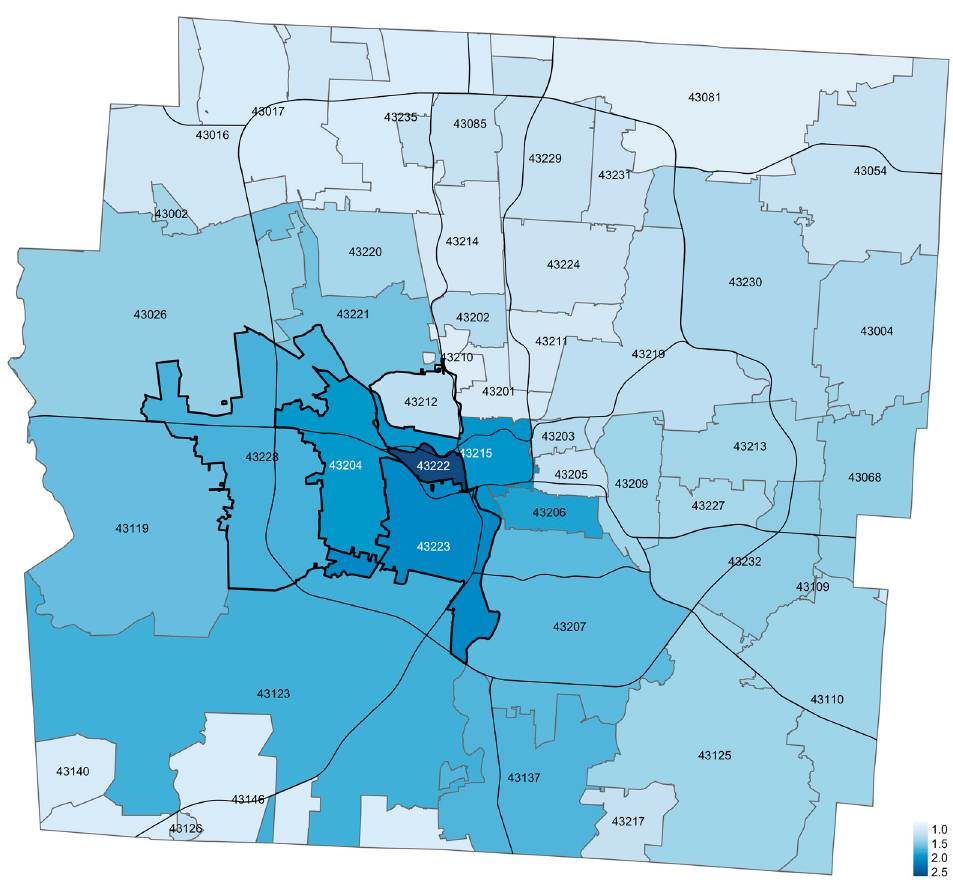
Figure 4. Franklin County, Ohio Bicycle Injury Density Map from 1 January 2015 to 28 February 2021. Units are injury events per 10,000 children per year, all years (Smoothed). Zip codes are noted with numbers and borders.